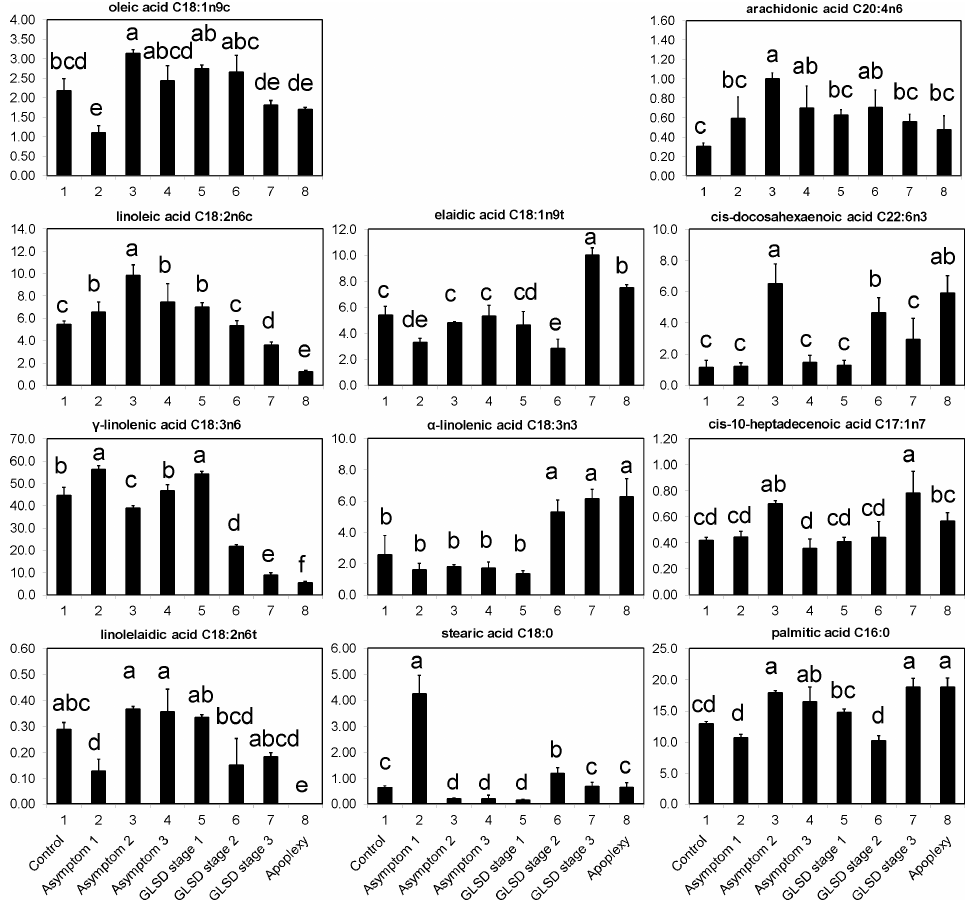
Figure 5. Fatty acids in asymptomatic and symptomatic leaves of vines affected by brown wood streaking, grapevine leaf stripe and apoplexy; their levels (%) were usually higher in asymptomatic leaves than in control leaves. The legend is as in Figure 6. Error bars = standard deviations ( n = 4); different letters above the columns denote statistical differences (Tukey’s test; P ≤ 0.05).